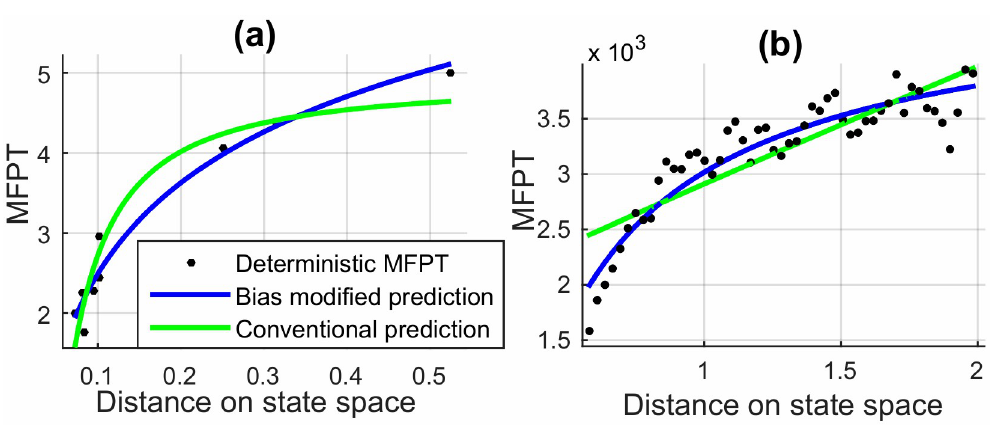
Fig 10. MFPT estimation for the angular velocity profile on state space for the motion of a passive RW on a ramp. (a) Step-wise MFPT comparison for experimental data and (b) for simulated